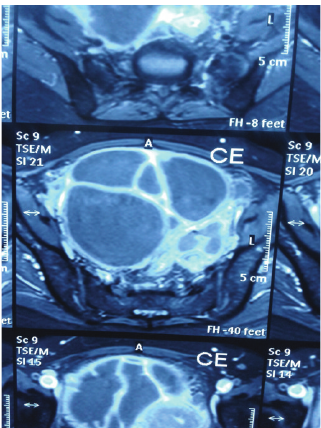
Figure 3: MRI of pelvis showing bilateral adnexal mass with septations.